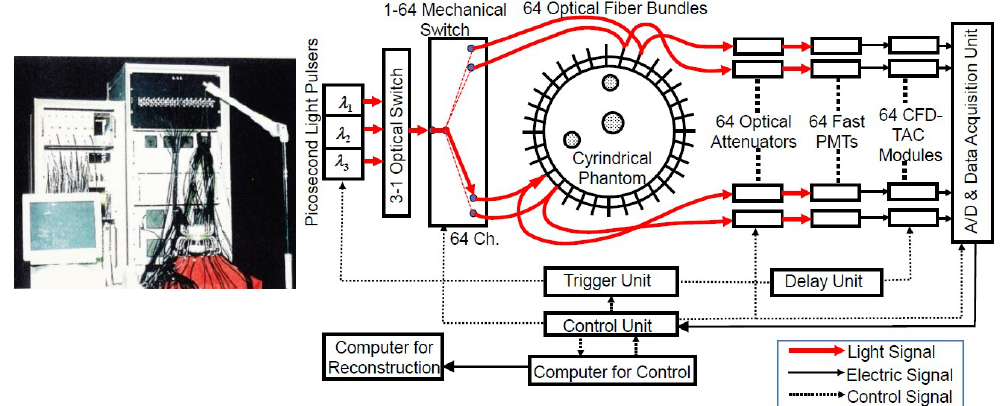
Figure 9. Photo and block diagram of the 64-channel TD-NIRS system developed by the group in Japan. Modified from Reference [45]. Japan. Modified from Reference